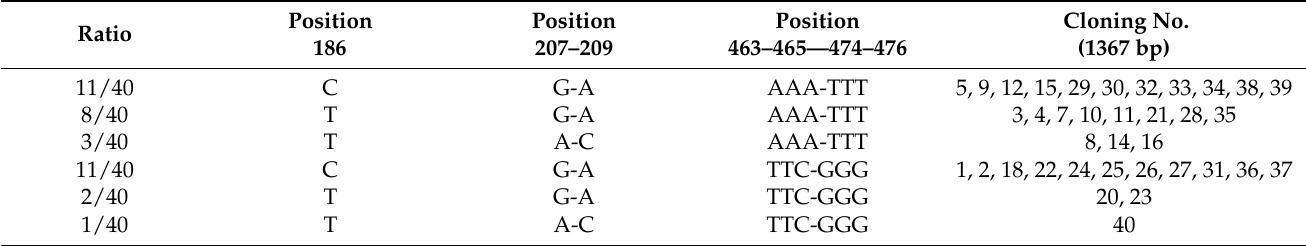
Table 3. Different 16S rRNA gene sequences in strain